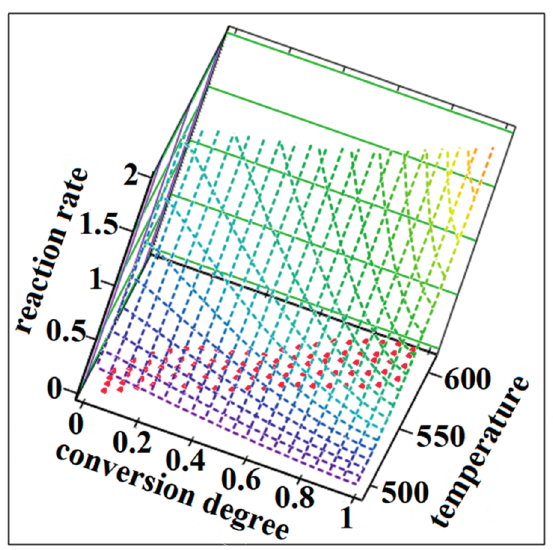
Figure 11. The reaction rate surfaces in 3D space with the coordinates ( β ·d α /d T ; α ; T ) for the SB2